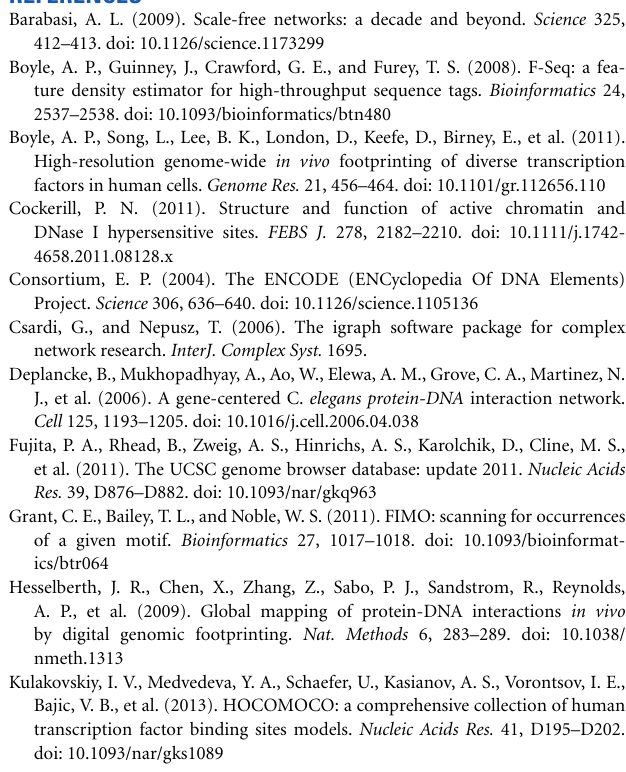
Table S1 | Complete list of datasets used in this study. Figure S1 | The number of footprints is shown as a function of the applied thresholds on statistical significance. Figure S2 | Genome browser screenshot showing a genomic region along with footprint calls at different p -values [ − 10 ∗ log10(p)]. Figure S3 | Each set of footprints has been compared to the set of footprints obtained at a lower p -value; the fraction of overlap is shown as a function of the p -value [ − 10 ∗ log10(p)]. Figure S4 | The total number of footprints and the number of footprints generating an edge in the TF-TF interaction network are shown as a function of the sampled reads. Figure S5 | Degree distribution for TF-TF networks (solid lines) and corresponding random networks (dashed lines). Figure S6 | Average path length and clustering coefficient for TF-TF networks (black lines) and corresponding random networks (red